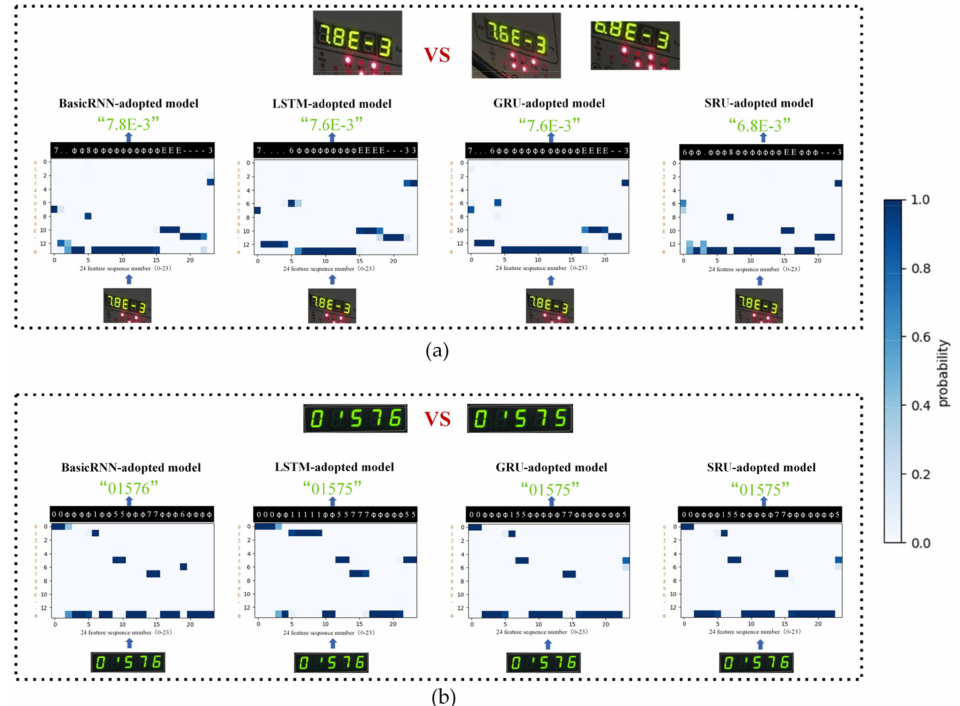
Figure 10. Correct prediction of BasicRNN-adopted model. ( a ) The label distribution of “7.8E-3” through the four models. “7.8E-3” didn’t appear in B 1 , while “7.6E-3”and “6.8E-3” appeared in B 1. ( b ) The label distribution of “01576” through the four models. “01576” didn’t appear in B 1 , while “01575” appeared in B 1